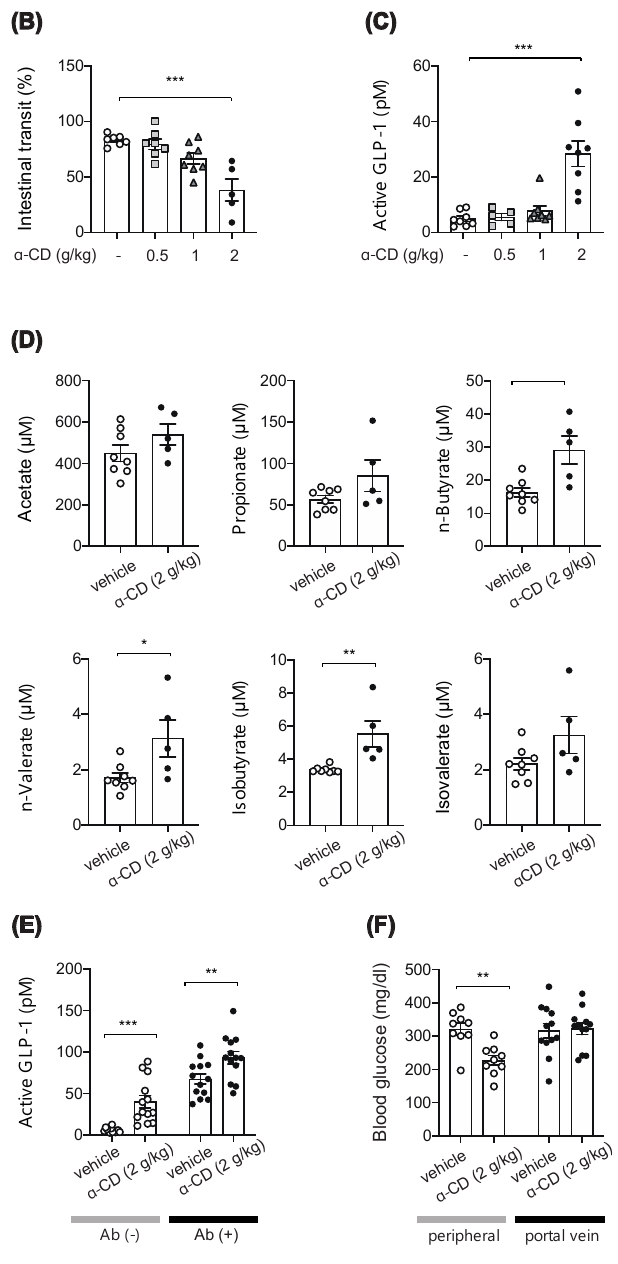
Figure 2. Effect of 2 g/kg α -CD on blood glucose and GLP-1, intestinal transit and SCFA levels. ( A ) Blood glucose was measured after glucose (2 g/kg) loading with or without α -CD (0.5, 1, 2 g/kg) ( n = 8–15). * p < 0.001 (control vs. 1 g/kg α -CD), and § p < 0.001(control vs. 2 g/kg α -CD). ( B ) Small intestinal transit in WT mice pre-administered with α -CD (0.5, 1, 2 g/kg) ( n = 5–7). ( C ) Plasma GLP-1 levels in the portal vein (0.5, 1, 2 g/kg) ( n = 5–8). ( D ) Plasma SCFA levels in the portal vein at 30 min after 2 g/kg α -CD administration ( n = 6–8). ( E ) Plasma GLP-1 levels in the portal vein at 30 min after 2 g/kg α -CD administration in the WT mice with [Abs (+)] or without [Abs ( − )] Abs-treatment ( n = 13). ( F ) Blood glucose levels in peripheral and portal vein at 30 min after 2 g/kg α -CD adminis- tration ( n = 9–12). Each data is plotted as a circle. Bars depict mean ± SEM. * p < 0.05, ** p < 0.01, and *** p < 0.001 by one-way ANOVA ( A – C ) plus Tukey’s post hoc analysis ( A – C ) or by unpaired-Student t -test ( D – F